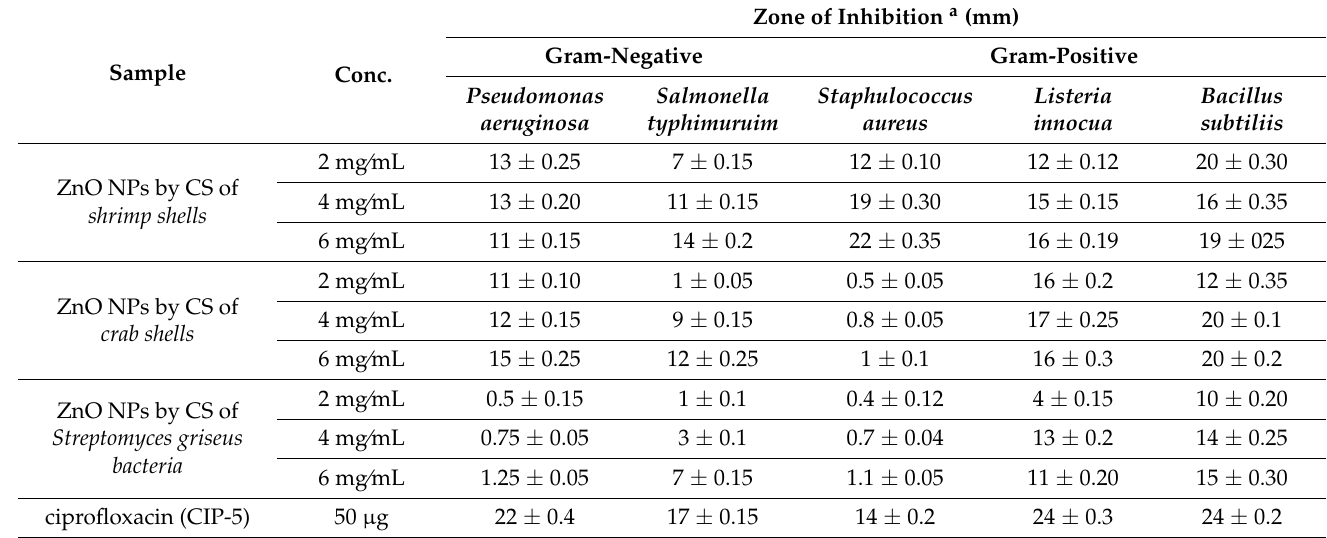
Table 3. The zone of inhibition of ZnO NPs from chitosan of shrimp shells , crab shells , and Streptomyces griseus bacteria